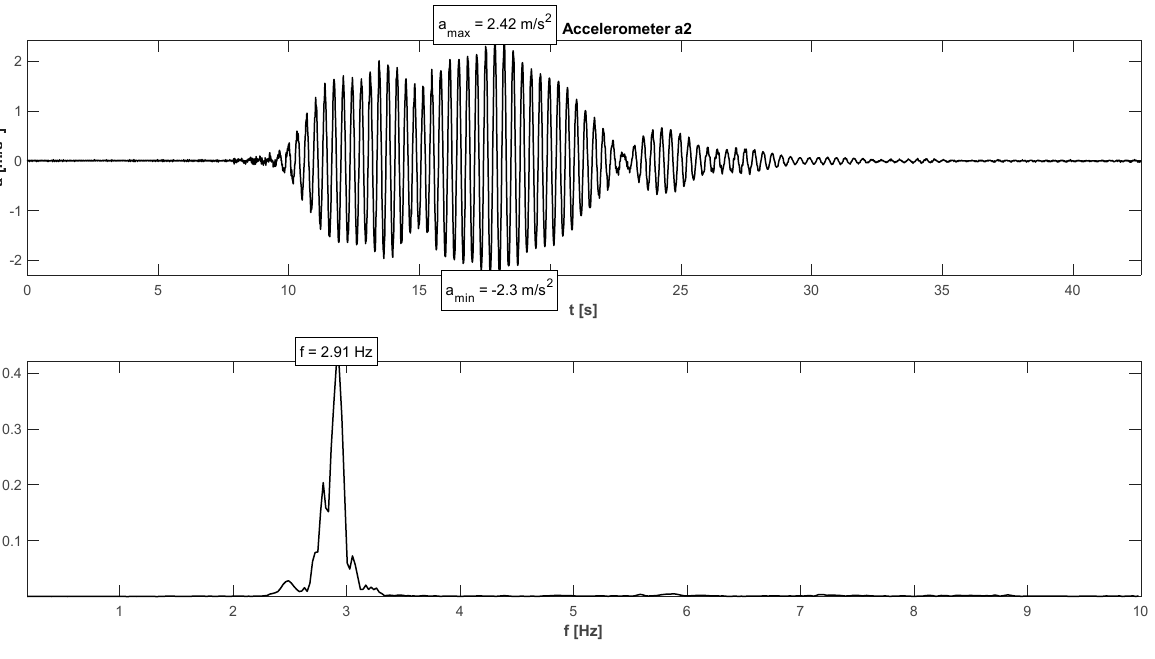
Figure 28. Signal of vertical vibrations in the time and frequency domain registered for the syn ‐ chronized running of 10 people.